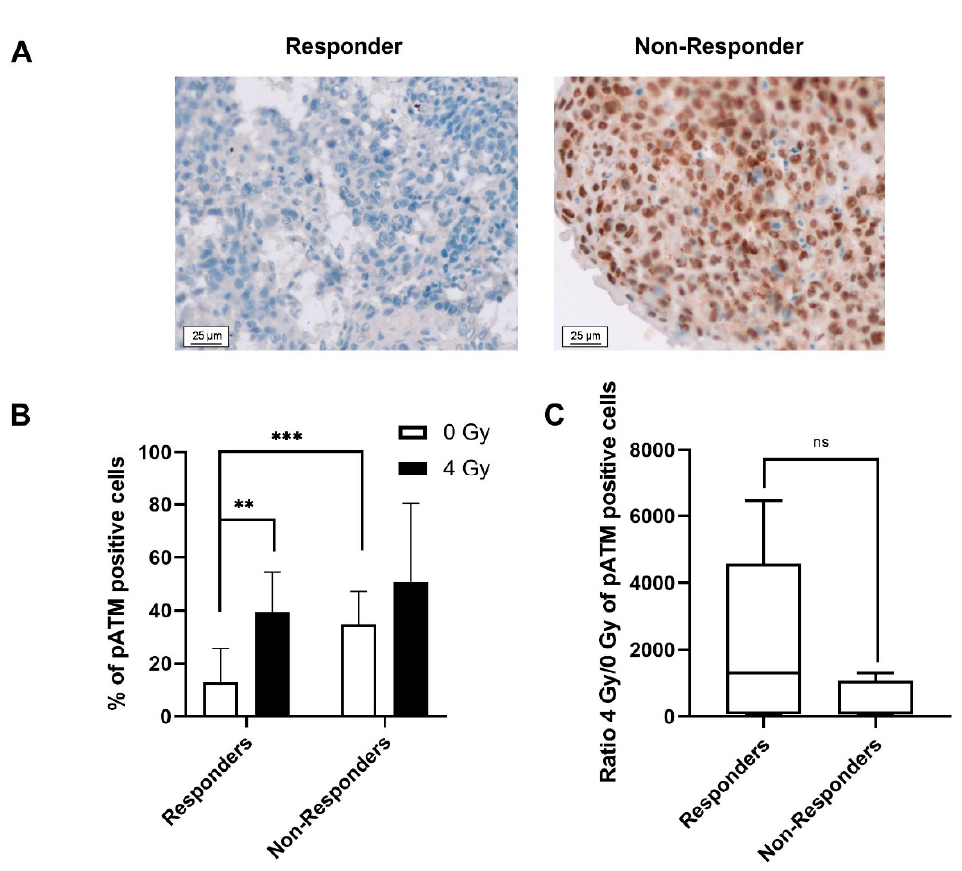
Figure 3. ( A ) Representative microscopic acquisition showing pATM in non-irradiated tumour slices for responders and non-responders. ( B ) Average percentage ± SD of pATM positive cells 24 h after 0 or 4 Gy irradiation for responder and non-responder patients. ( C ) Ratio of pATM expression after 4 Gy irradiation compared with 0 Gy for responder and non-responder patients. Two slides and a minimum of 200 nuclei per slide were analysed per condition. Student’s t -test was used for statistical analyses ( ns p > 0.05, ** p < 0.01, *** p < 0.001). Concerning the γ -H2AX foci, Figure 4A shows representative cells at 24 h containing γ -H2AX foci in non-irradiated or irradiated cells from a responder patient. Figure 4B pre- sents the mean number ± SD of γ -H2AX foci per cell. When the two groups are compared, it emerges that in the absence of irradiation, the mean number of γ -H2AX foci is signifi- cantly higher (** p < 0.01) for non-responder patients (3.2 ± 0.5) compared with responder patients (0.8 ± 0.7). After irradiation, no significant difference was observed between the residual γ -H2AX foci of the responder (2.5 ± 2.1) and non-responder patients (3.9 ± 2.3). Figure 4C shows two different profiles of the 4 Gy/0 Gy ratio, depending on whether the patients are responders or non-responders. For this marker, the γ -H2AX ratio obtained at 24 h is higher (* p < 0.05) for responder patients than for non-responder patients. The threshold for classifying patients has been determined at 1.4 γ -H2AX foci for non-irradi- ated cells. Moreover, in contrast to CD44 and pATM markers, the γ -H2AX ratio 4 Gy/0 Gy was significantly different between responders and non-responders (* p < 0.05). The threshold ratio was, therefore, calculated and set at 1.6.